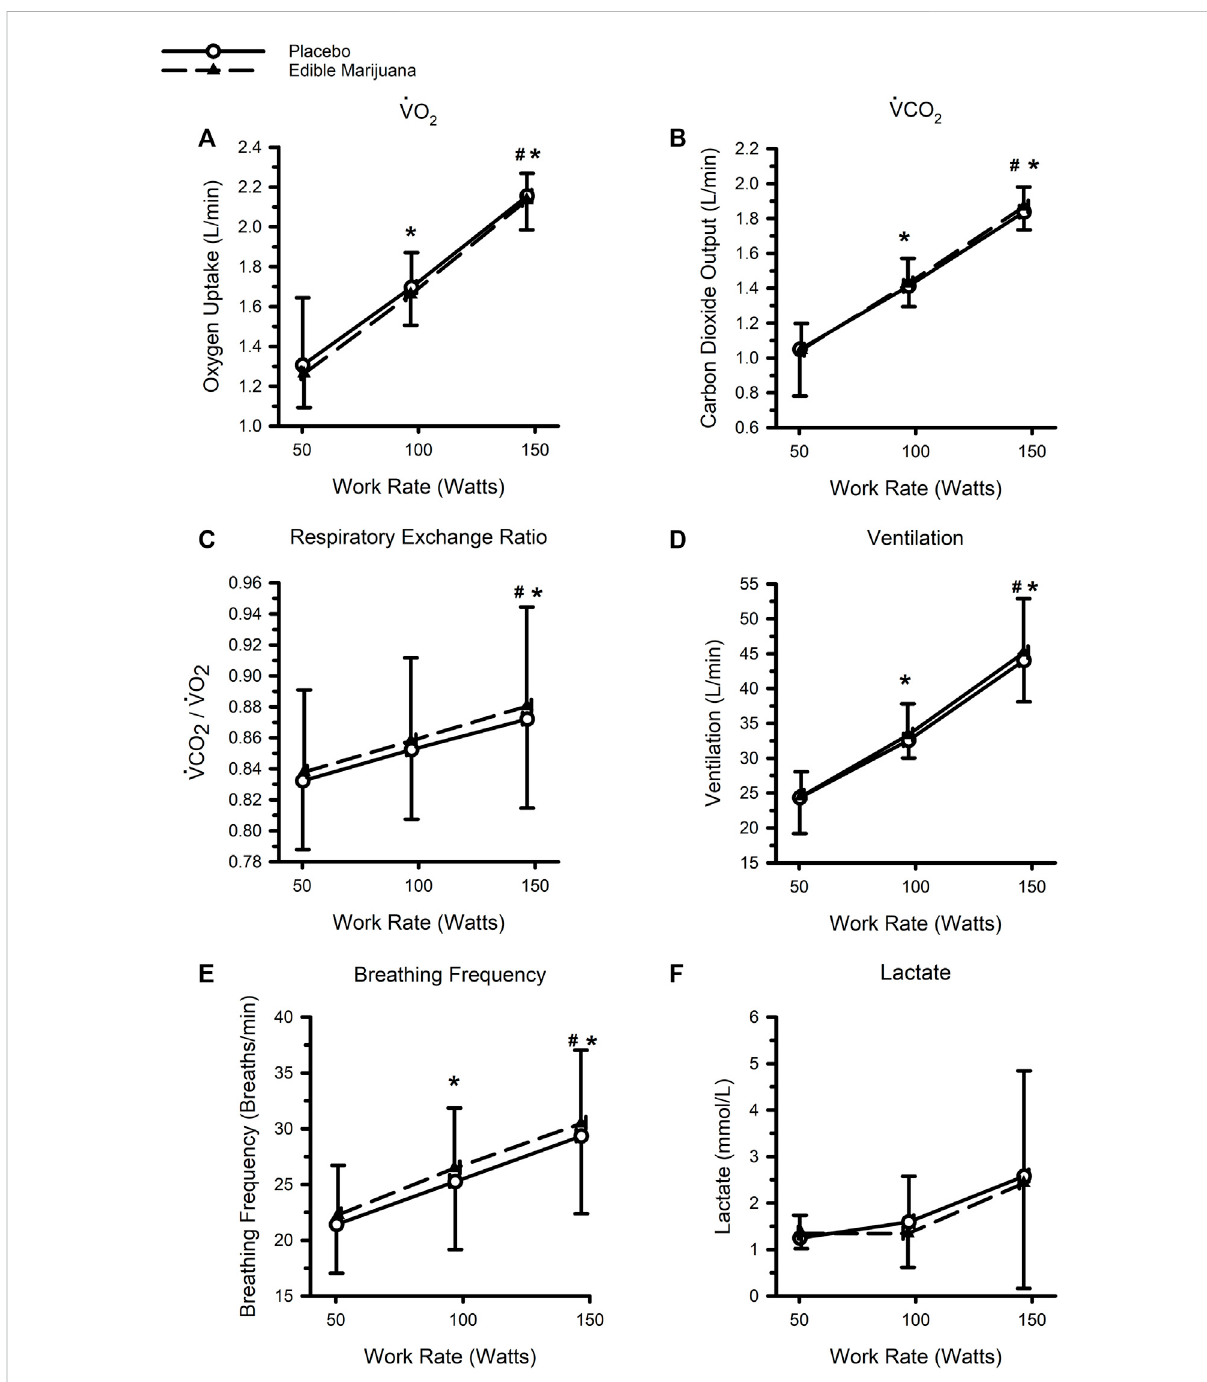
FIGURE 3 Ventilatory and metabolic responses to standardized stationary cycle ergometer exercise following ingestion of edible marijuana (10 mg THC) or placebo: Oxygen uptake (V _ O 2 ) (A) , Carbon dioxide output(V _ CO 2 ) (B) , Respiratory exchangeratio (C) , Ventilation (D) , Breathing Frequency (E) , and Circulating concentrations of lactate (F) . For all fi gures, data are presented as mean and SD. * depicts different from the 50 W (main effect of work rate; p < 0.05), # depicts different from 100 W (main effect of work rate; p <